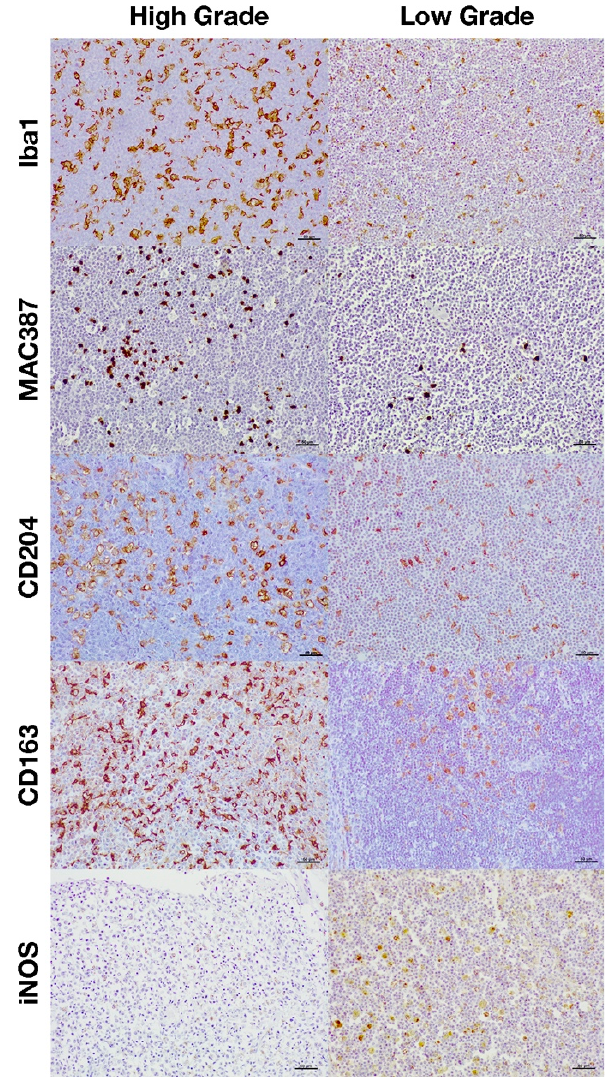
Figure 2. Immunohistochemical expression of the different macrophage markers according to the histological grade.